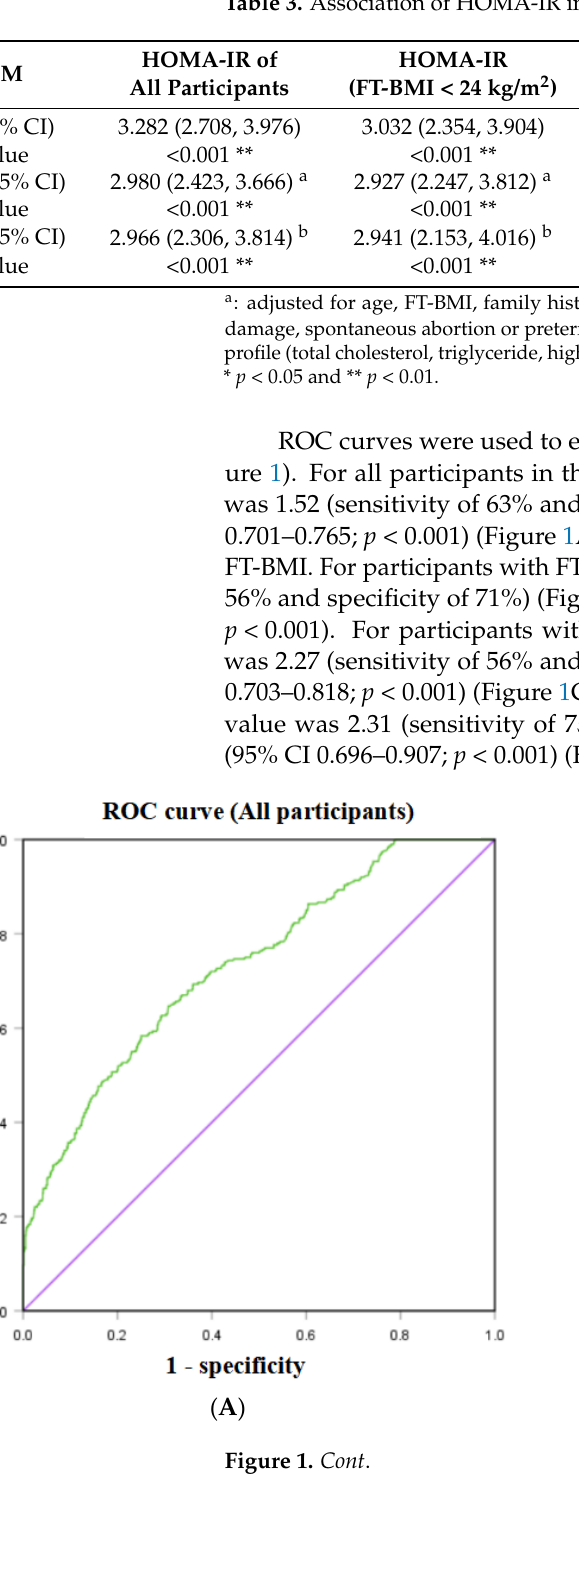
Table 3. Association of HOMA-IR in early pregnancy with GDM.